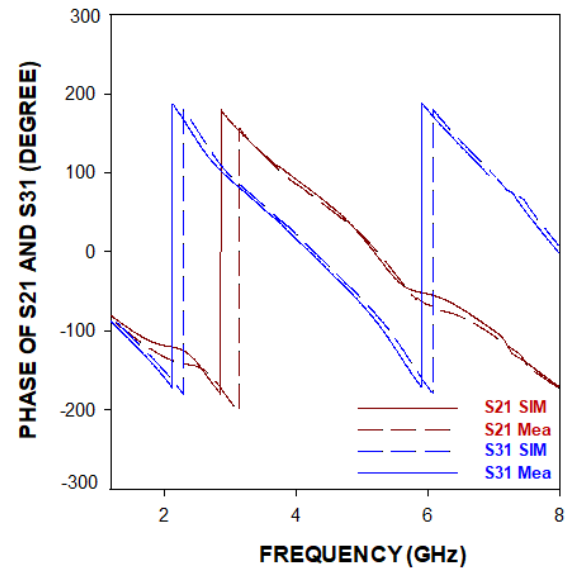
Fig.9. Frequency response of the manufactured dual-band patch coupler